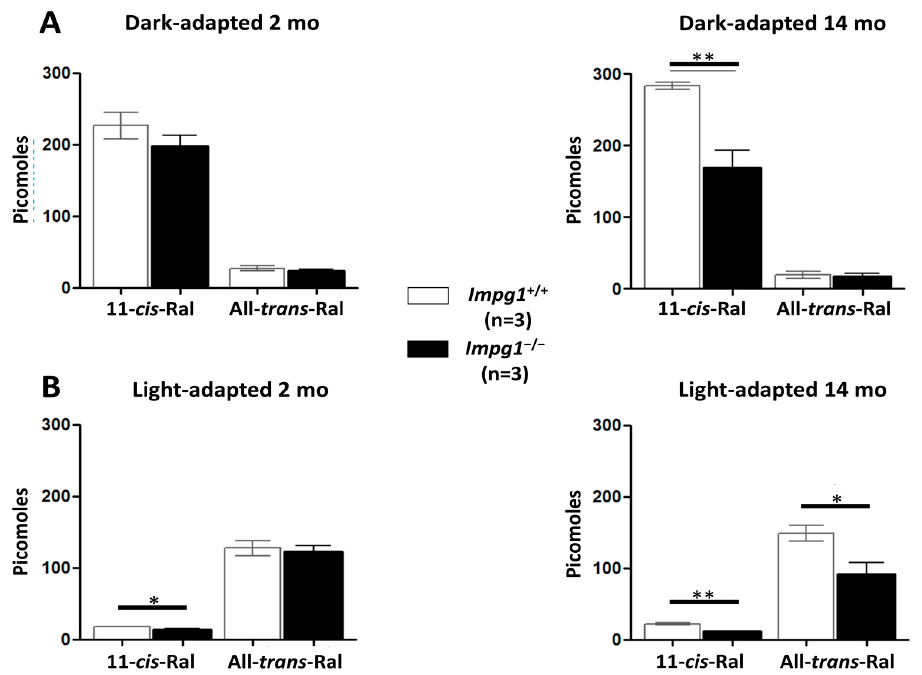
Figure 4. Decrease in retinoid concentration in Impg1 − / − mice. Under dark-adapted conditions, the 11- cis -retinal (11- cis -Ral) concentration is maximal ( A ), whereas the all- trans -retinal (All- trans -Ral) concentration is maximal after 10 min of constant light exposure ( B ). Impg1 − / − mice seem to show normal photoisomerization, but the basal retinoid concentration is 40% lower than wild-type mice at 14 months of age under light exposure. Student’s t -test ( n = 6 eyes); * p < 0.05, ** p < 0.01. Taken together, the significant decrease in the thickness of the ORL, consistent with the reduced ERG recordings and basal retinoid concentration, suggests photoreceptor degeneration in Impg1 − / −